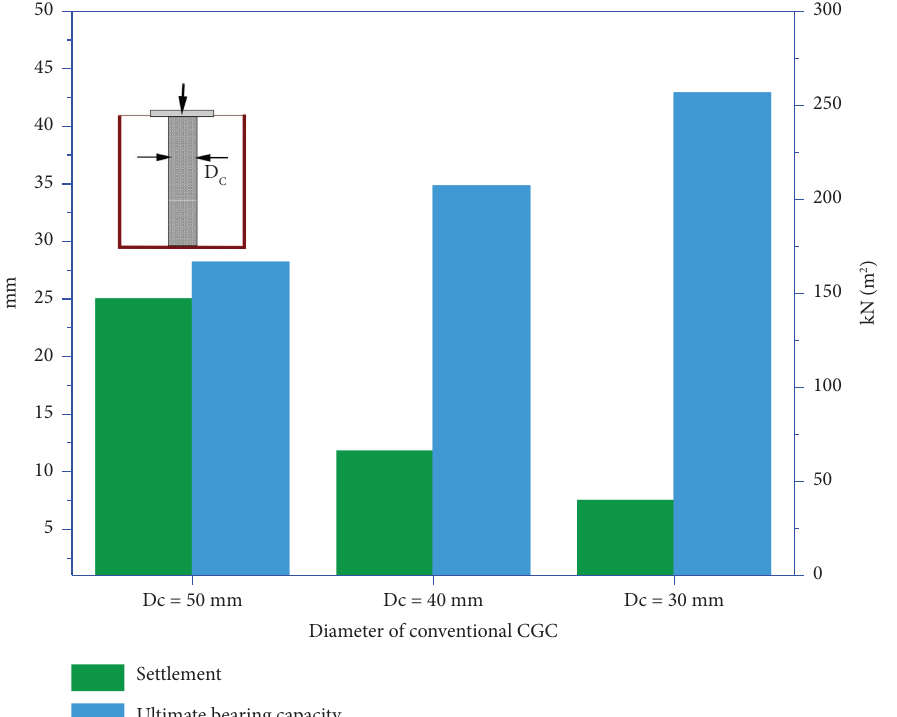
Figure 11: Efect of column diameter on ultimate bearing capacity- settlement relationship for improved soft clay